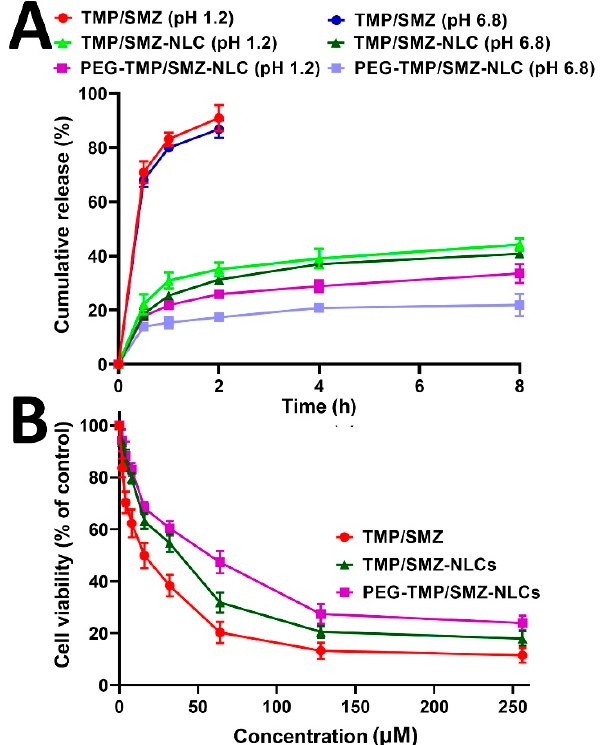
Figure 5. ( A ) Cumulative drug release from TMP/SMZ-NLCs and PEG-TMP/SMZ-NLCs, and ( B ) cell toxicity effects of TMP/SMZ-NLCs and PEG-TMP/SMZ-NLCs, compared to TMP/SMZ, 3 months after the preparation. The data were expressed as mean ± SD (n = 3).